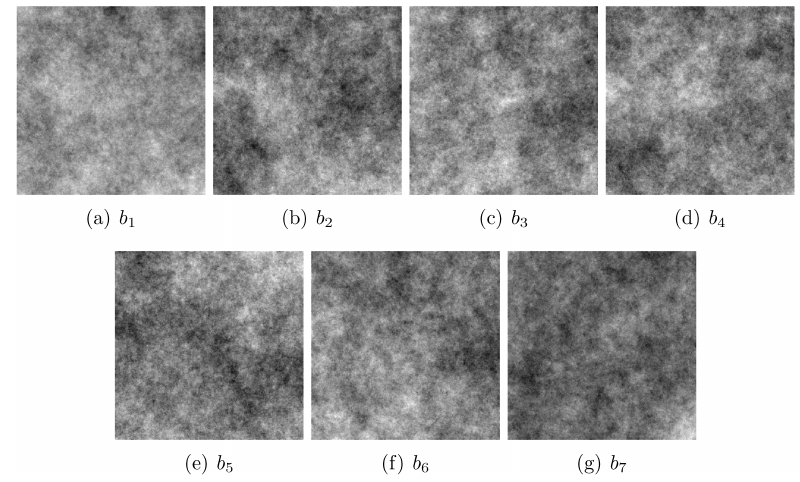
Figure 3. The sevenspectral bands of the MSI with high generated complexity ( H = 0.1).